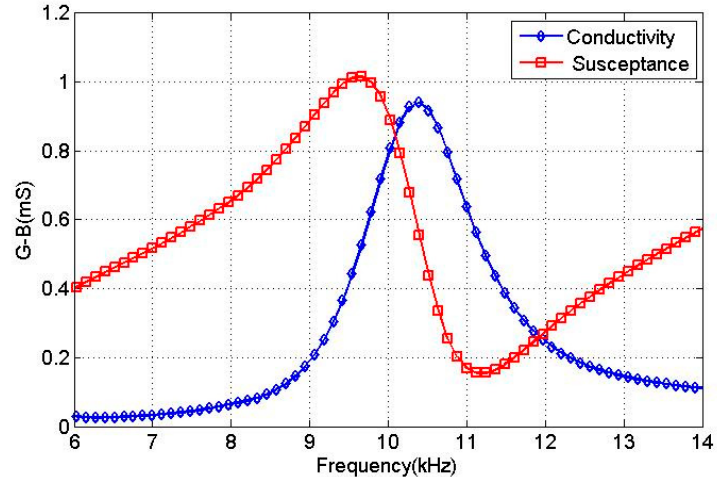
Figure 6. The conductivity curves of the transducer in water.